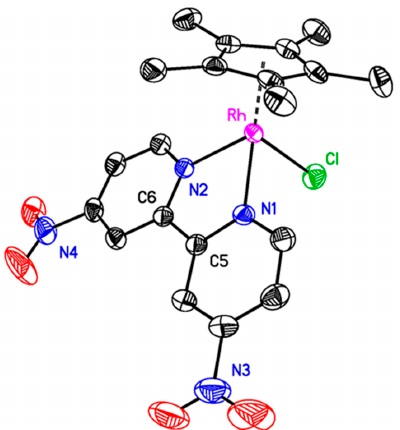
Figure 1. Solid-state structure (X-ray diffraction (XRD)) of 3 . H atoms, PF 6 − counteranion, and one co-crystallized MeCN molecule omitted for clarity. Displacement ellipsoids are shown at 50% probability. Cyclic voltammograms (CVs) of 3 (ca. 1 mM) were collected in THF solution containing 0.1